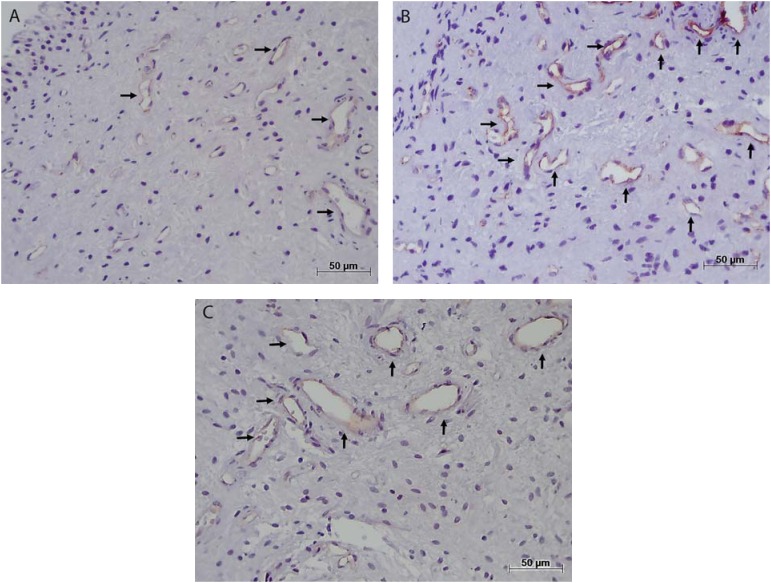
Blood vessels (CD31+) (arrows) in control group (A), at-home bleaching group (B), and in-office bleaching group 2 (C). Immunohistochemical staining; original magnifications 200×; A-C